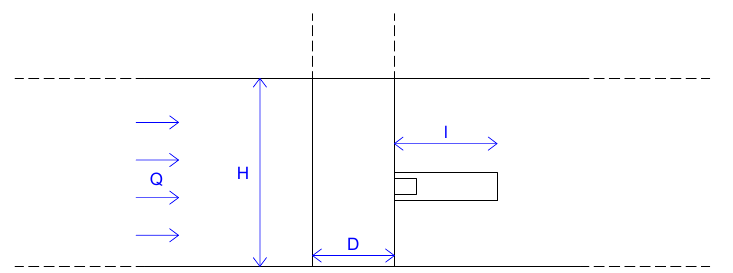
Figure 5. Longitudinal section of the experimental setup with the flag of length l clamped at the cylinder of diameter D , inlet flow rate Q , and height of flow H in the open